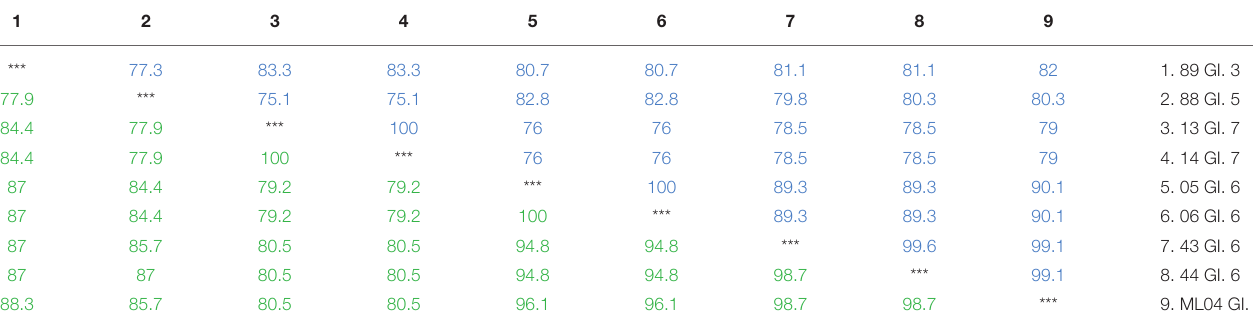
TABLE 4 | Nucleotide and amino acid homology analysis of the GI type in oysters and patients with diarrhea in Yantai,